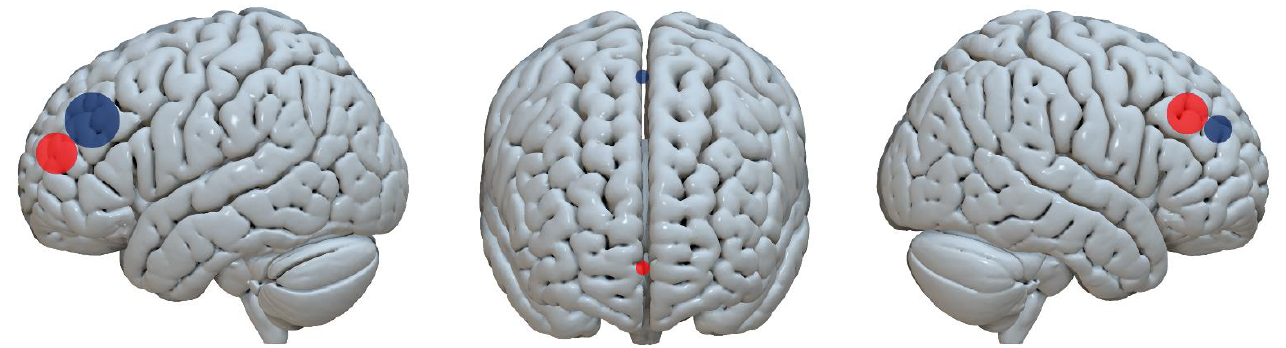
Figure 5. Type of stimulation and target regions of the included studies. Red dots indicate excitatory stimulation protocols (i.e., anodal tDCS and high-frequency rTMS) and blue dots indicate inhibitory stimulation (i.e., cathodal tDCS and low-frequency rTMS). The size of the dots corresponds to the number of studies that applied an excitatory or inhibitory protocol over a specific region. Brain images were modified from Surf Ice (https://github.com/neurolabusc/surf-ice) accessed on 17 March 2023).